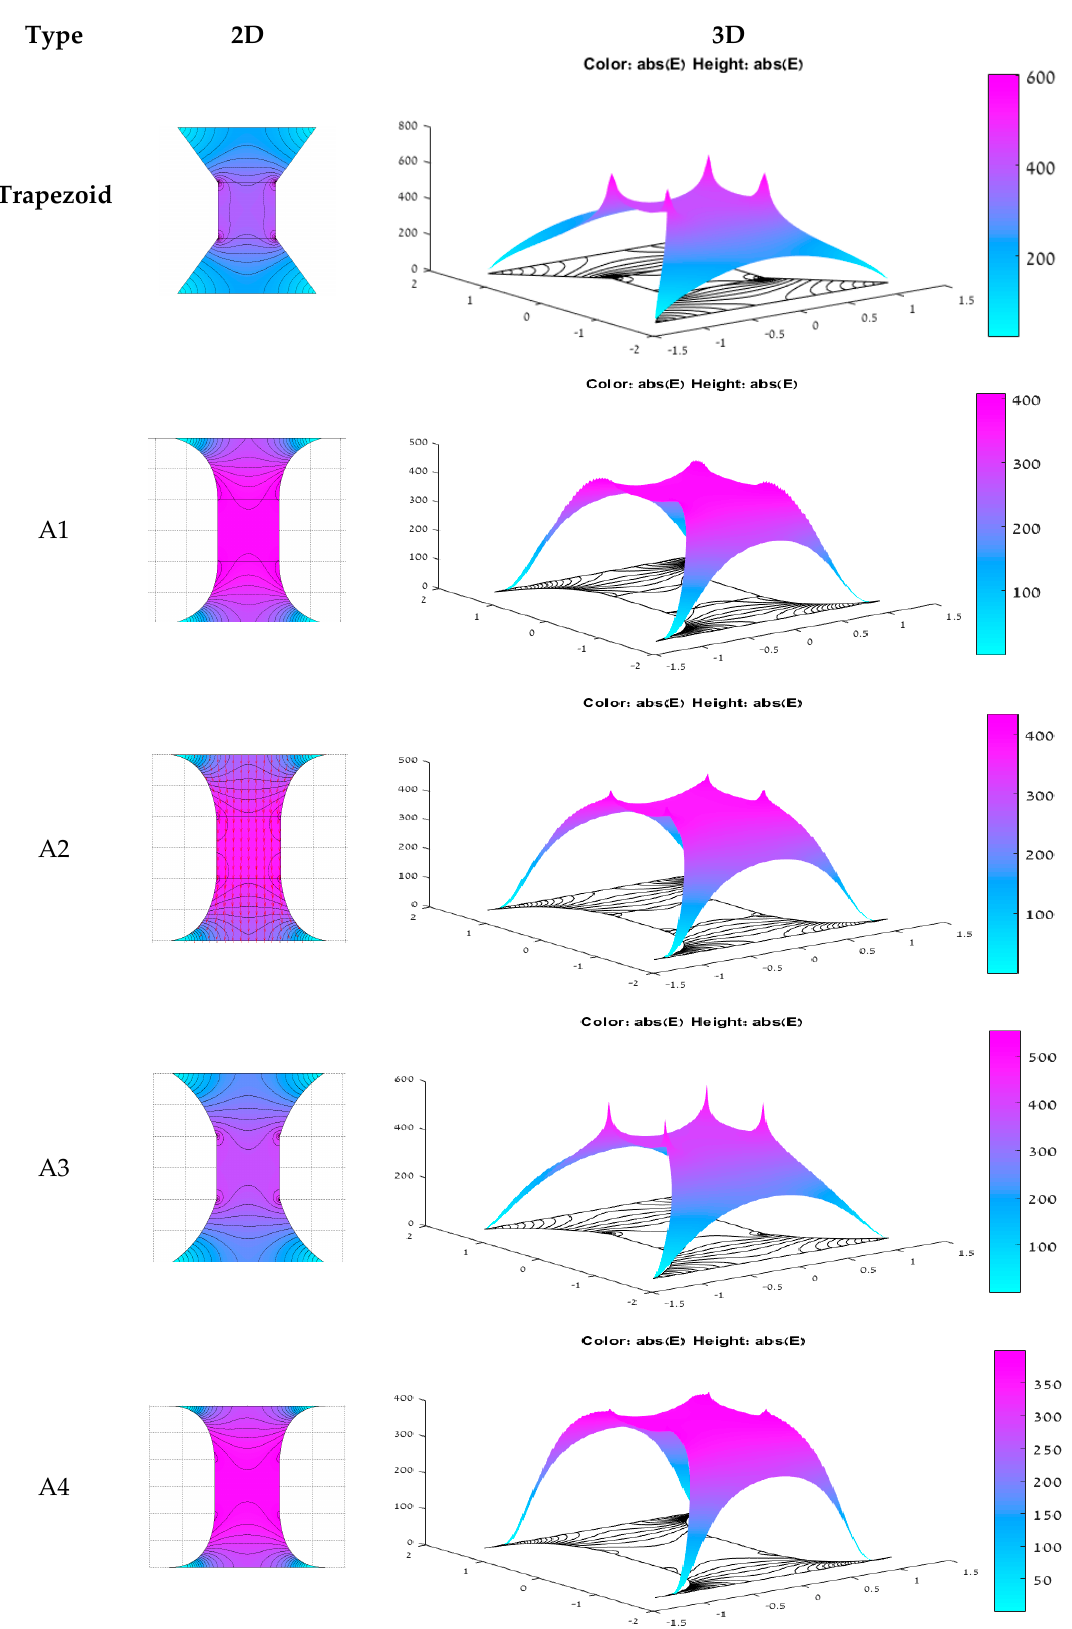
Figure 3. 2D and 3D electric field simulation for: Trapezoid, A1, A2, A3 and A4 resistors.